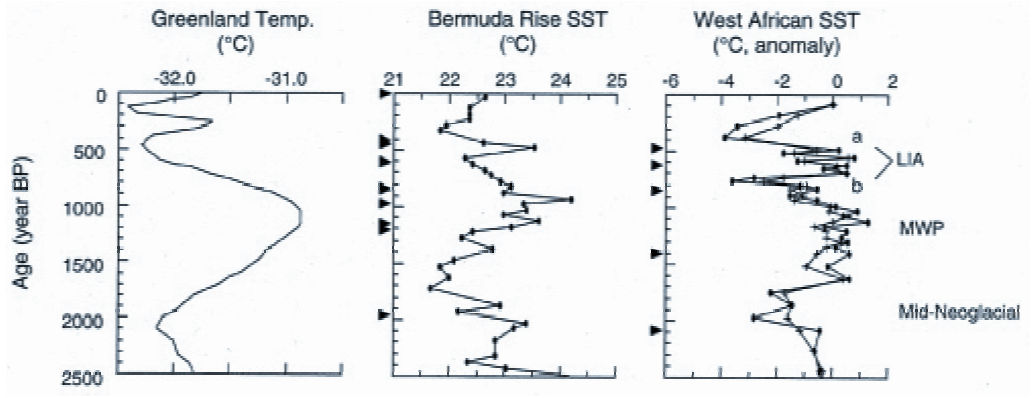
FIGURE 12. Examples of three large amplitude temperature records. Note low frequency variations agree on warming around the year 1000, but disagree in detail after 1500. of the above proxies. Fig. 9 shows these. Note that the total amplitude indicated is